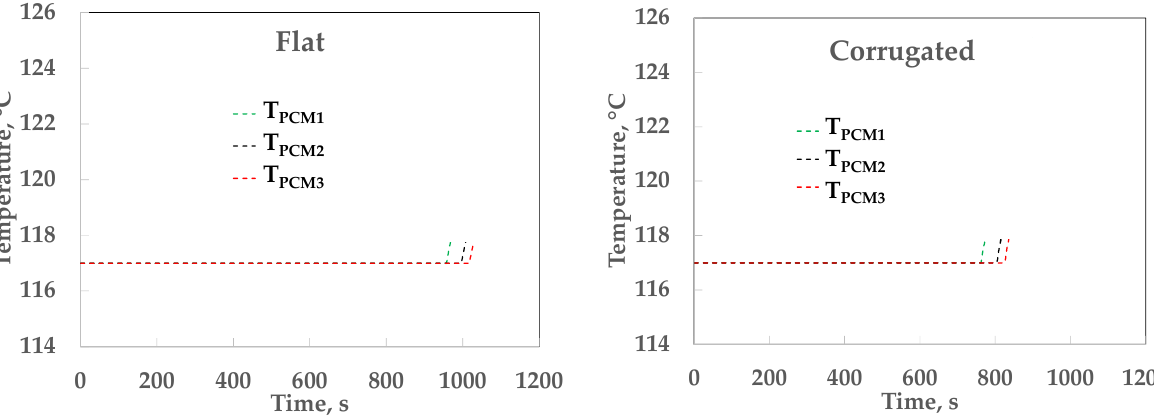
Figure 7. Axial temperature profile in the center of the PCM.